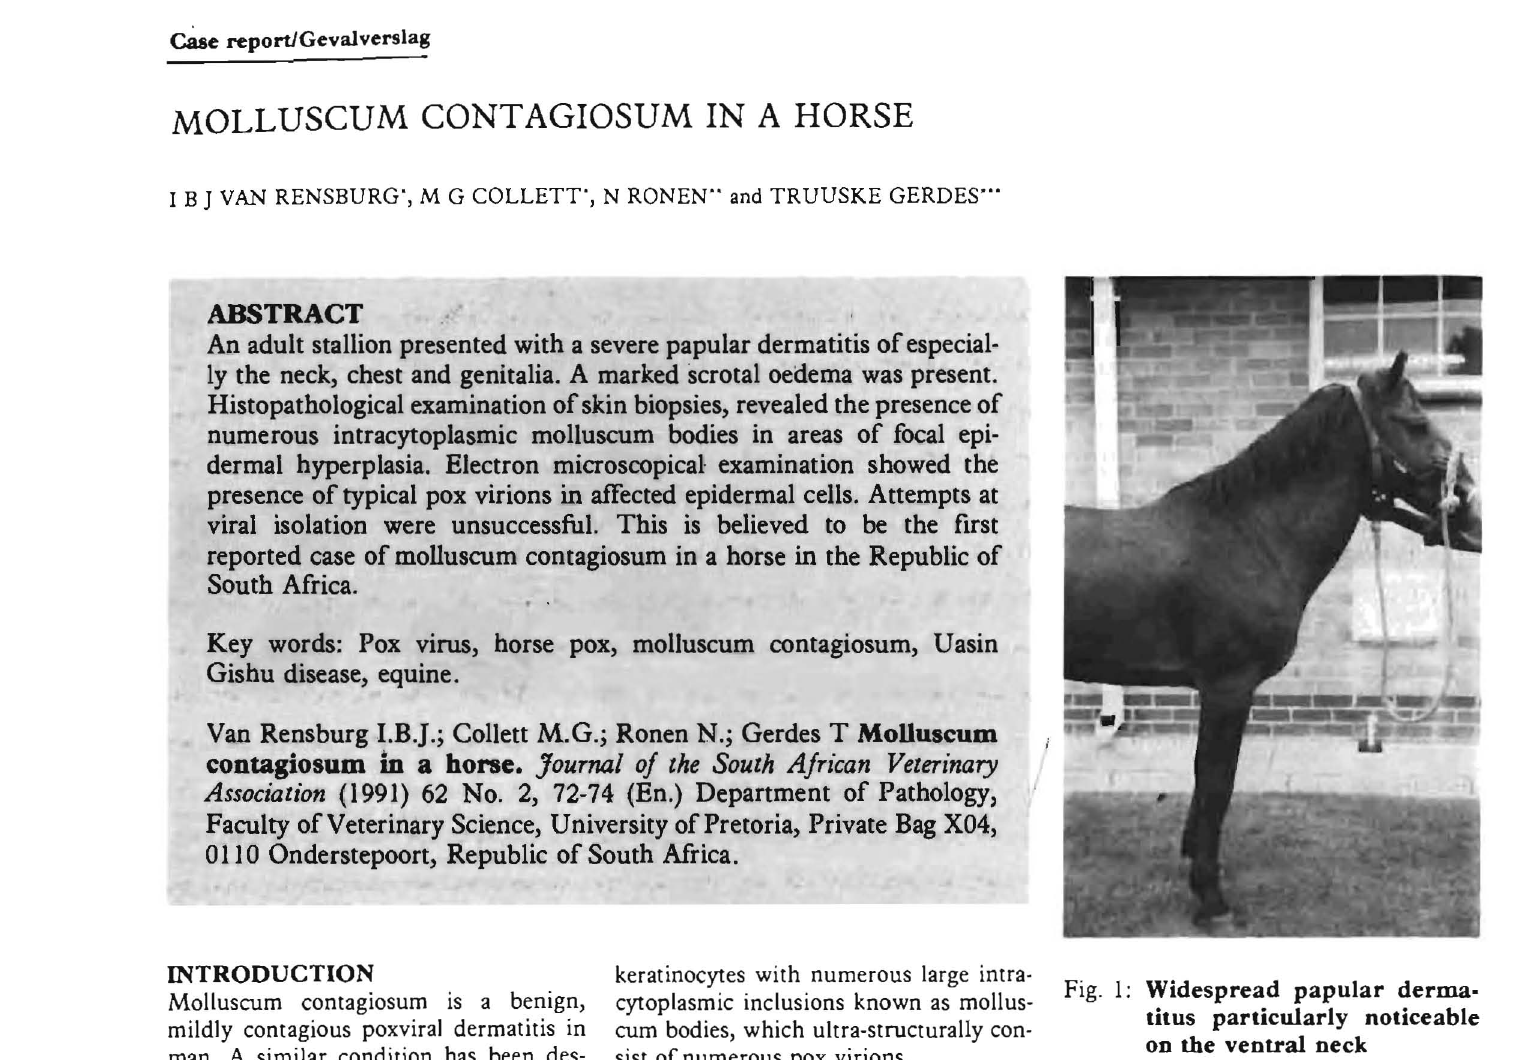
Fig. I: Widespread papular derma on the ventral neck